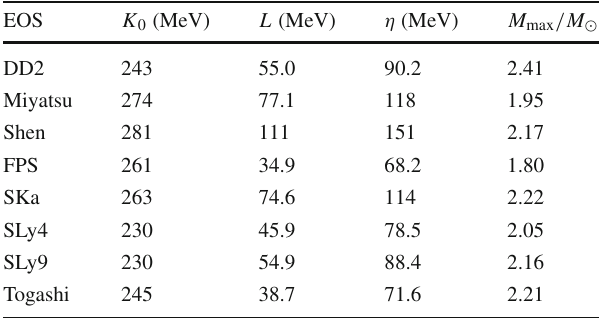
Table 1 EOS parameters adopted in this study, K 0 , L , and η , and the maximum mass, M max , of the neutron star constructed with each EOS